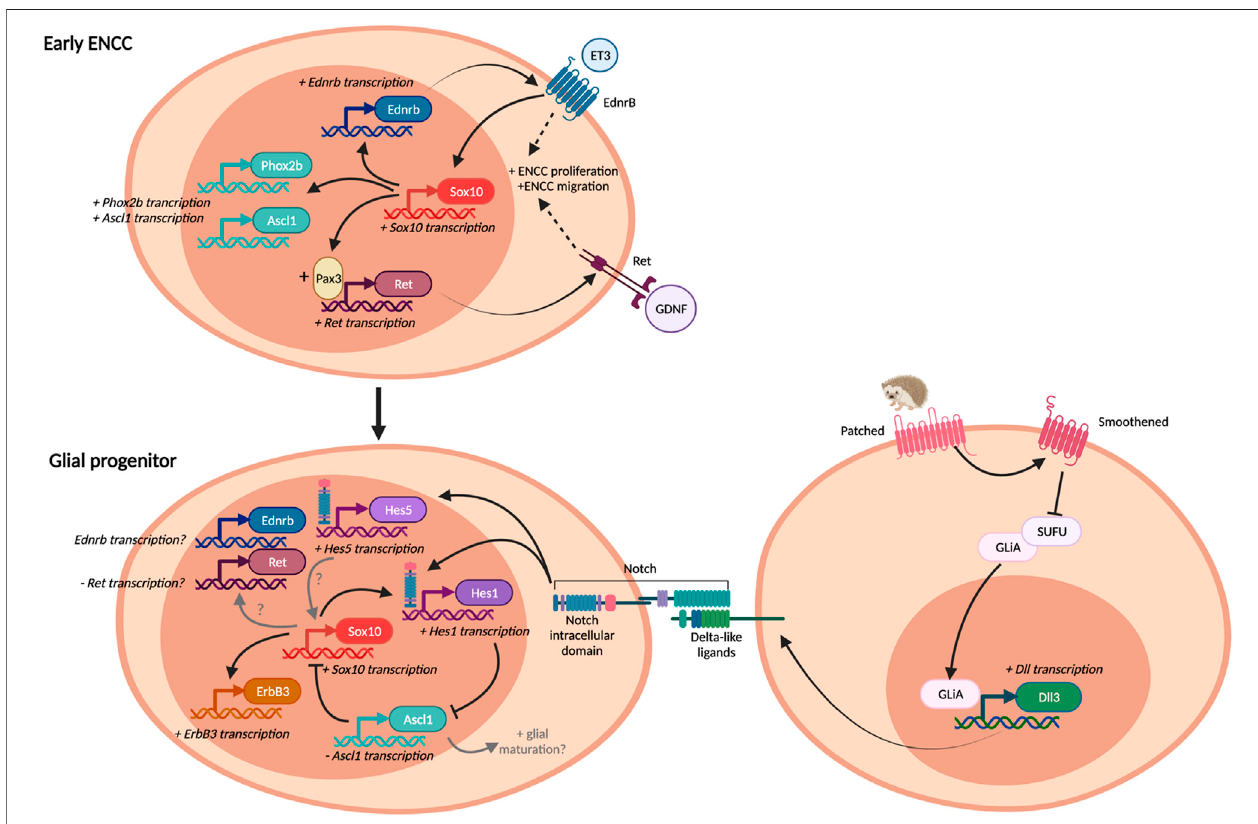
FIGURE 3 | Pathways in gliogenesis. Some pathways are commonly employed both in early ENCC development and enteric glial differentiation, but may play different roles in each situation, depending on the presence of other factors. Adapted and expanded from (Liu and Ngan, 2014).